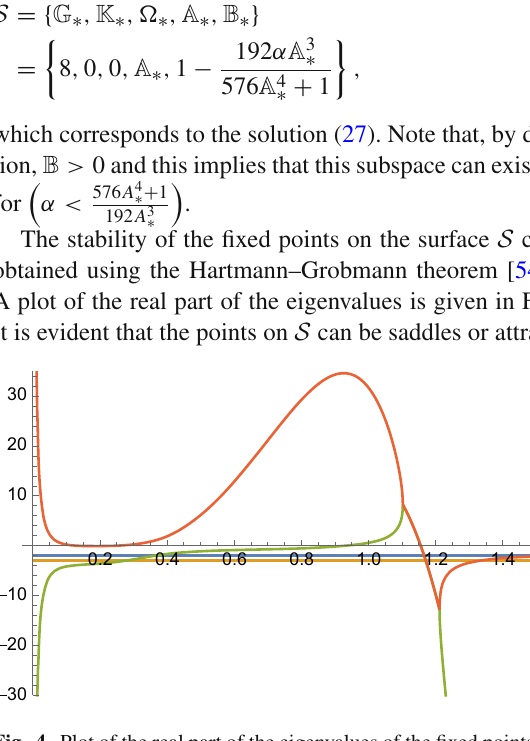
(cid:3) (cid:2) − βχ 2 χ 2 G arctan G . Here α has been chosen 0 0 0